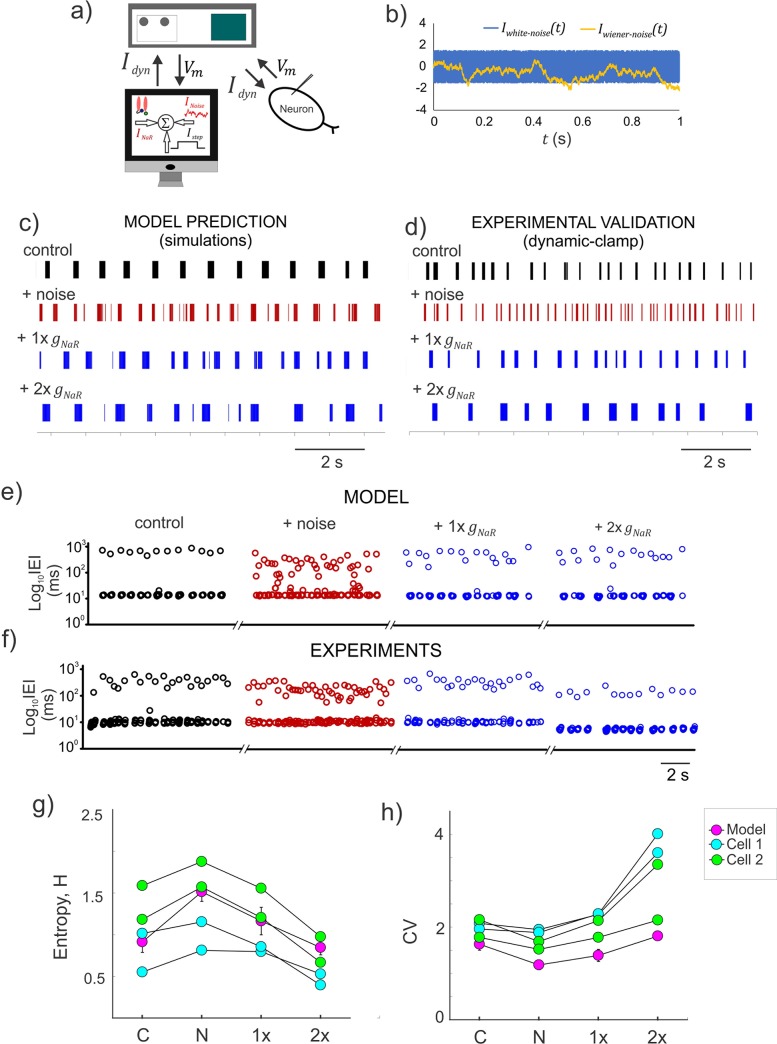
Resurgent Na+ current moderates the entropy of burst discharge.a) Schematic showing the experimental setup for real-time application of INaR and a stochastic input, INoise (see Methods); the dynamic-clamp current, Idyn is the instantaneous sum of INaR, a step current (Istep) and INoise. b) Simulated time series of two stochastic noise profiles used to disrupt the rhythmic burst discharge in Mes V neurons; Iwhite−noise was generated from a uniformly distributed random number and Iwiener−noise was generated from a normally distributed random number (see Methods). c–d) Raster plots showing patterns of inter-event intervals (IEIs) for the different conditions shown in the model (e), and during dynamic-clamp (f). e–f) Time series of IEI shown on a log scale for the different conditions shown in the model (e), and during dynamic-clamp (f). g–h) Shannon entropy (H) and coefficient of variability (CV) measured for IEIs under the different conditions presented in (c) and (d). Plotted circles for the model represent an average across 10 trials, while individual trials are presented for the data points from two cells. In both (g) and (h), C: control, N: after addition of random noise, 1x and 2x are supplements in gNaR values.